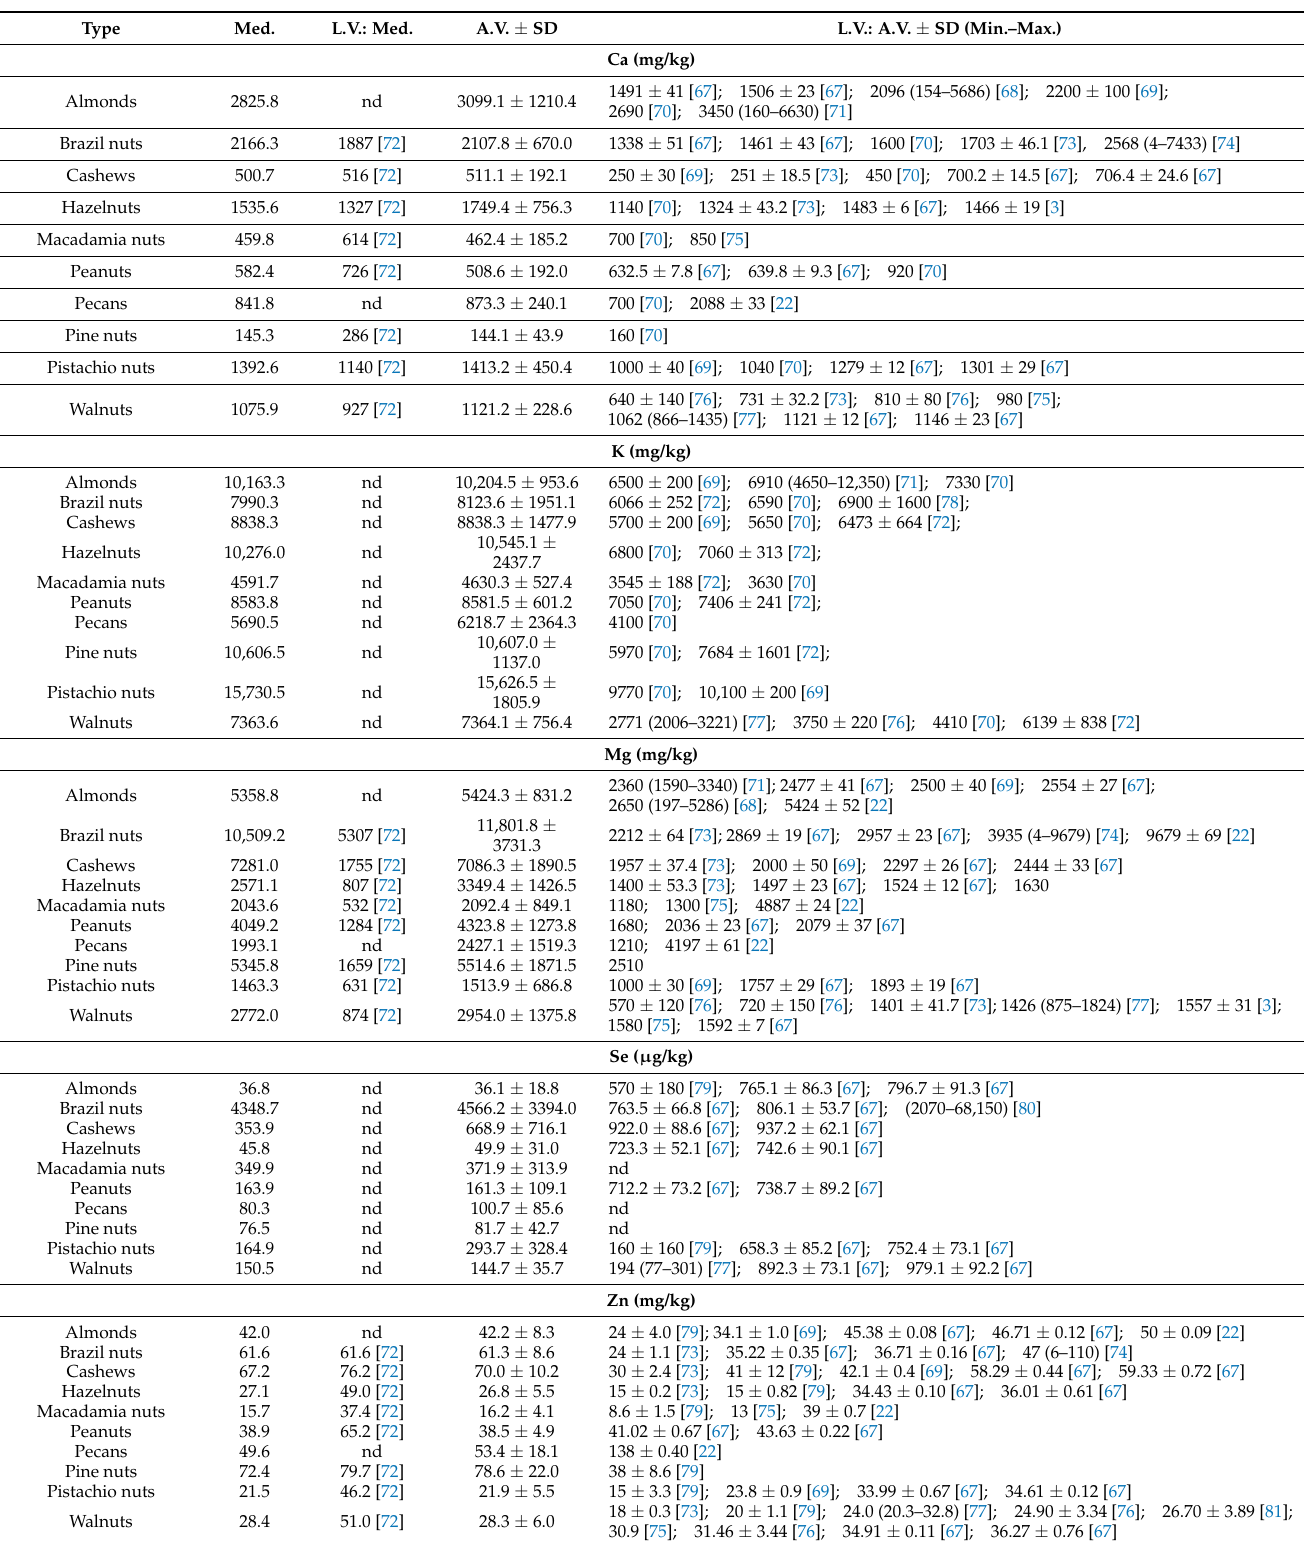
Table 5. The content of selected minerals in nuts in comparison to literature